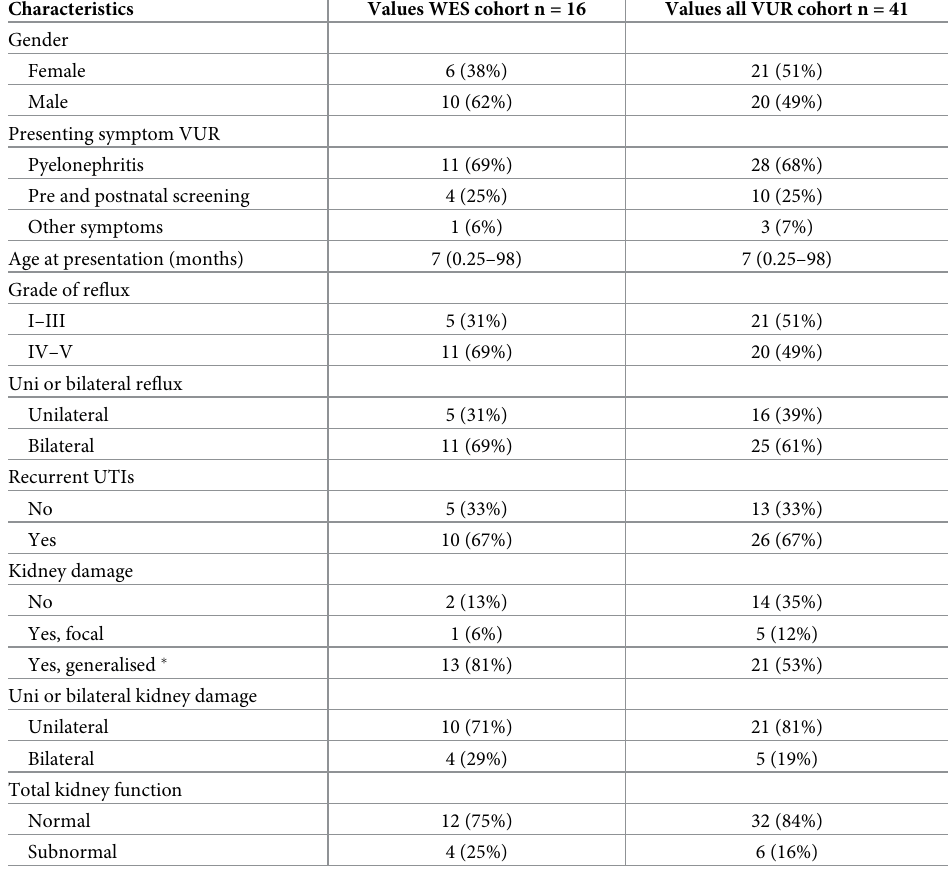
Table 1. Demographic data, VUR grades, kidney abnormalities and function for the whole-exome sequenced group and for the whole study group.